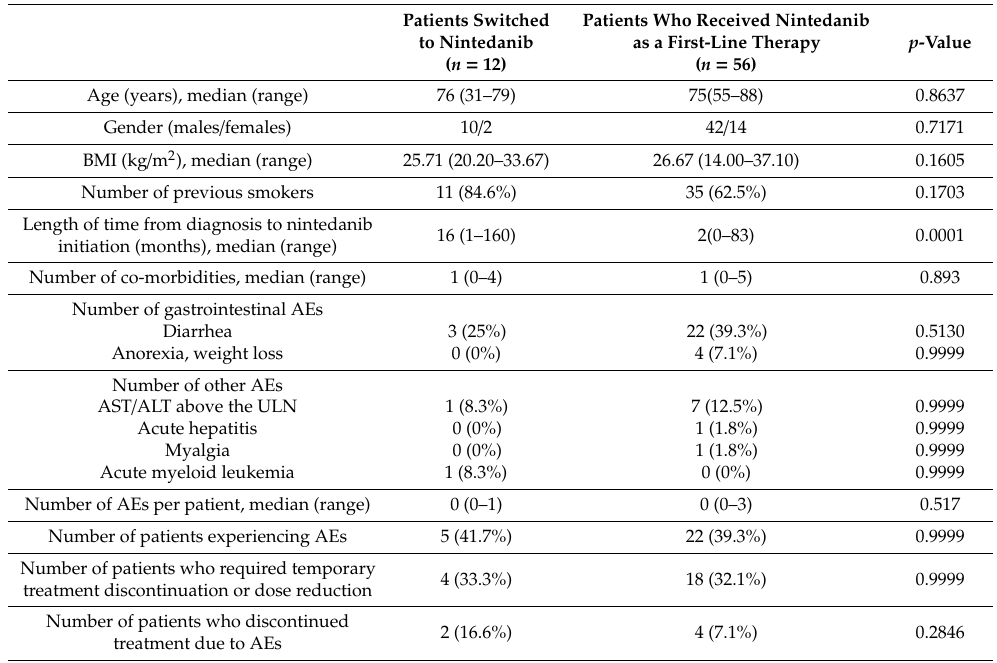
Table 2. Adverse events reported over the period of observation in patients switched to nintedanib and those who received nintedanib as a first-line therapy. (AE = adverse event; ALT = alanine transaminase; AST = aspartate transaminase; Pts = patients; ULN = upper limit of normal).